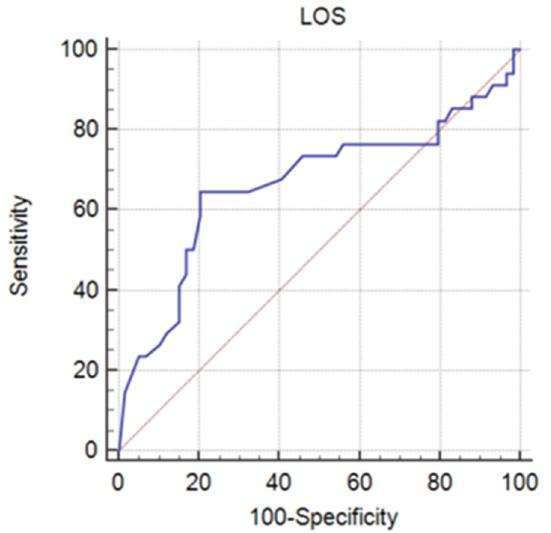
Figure 6. ROC curve for the length of hospitalization (LOS) variable.